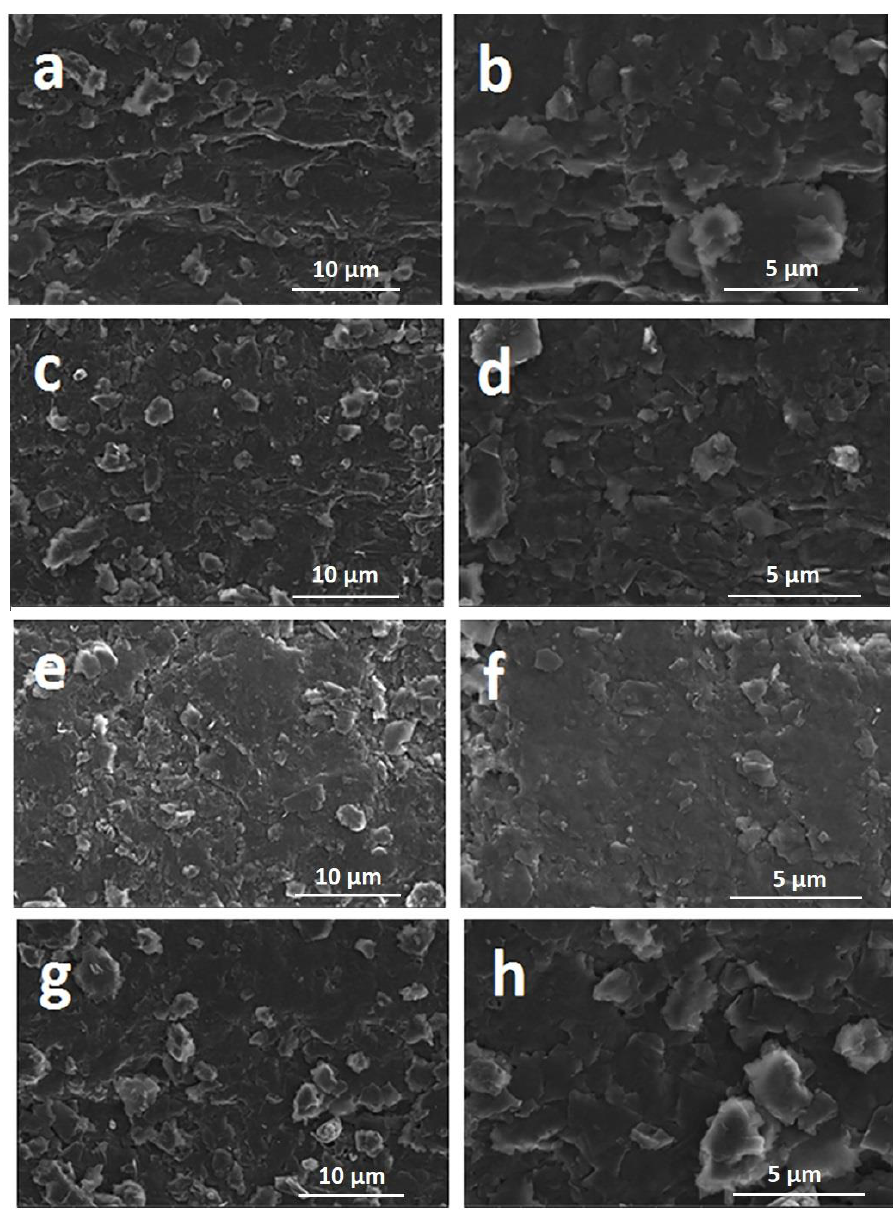
Figure 2. SEM images of ( a , b ) PGE, ( c , d ) GO-PGE, ( e , f ) IL-PGE, and ( g , h ) GO-IL-PGE with the resolutions of 10 and 5 µm.